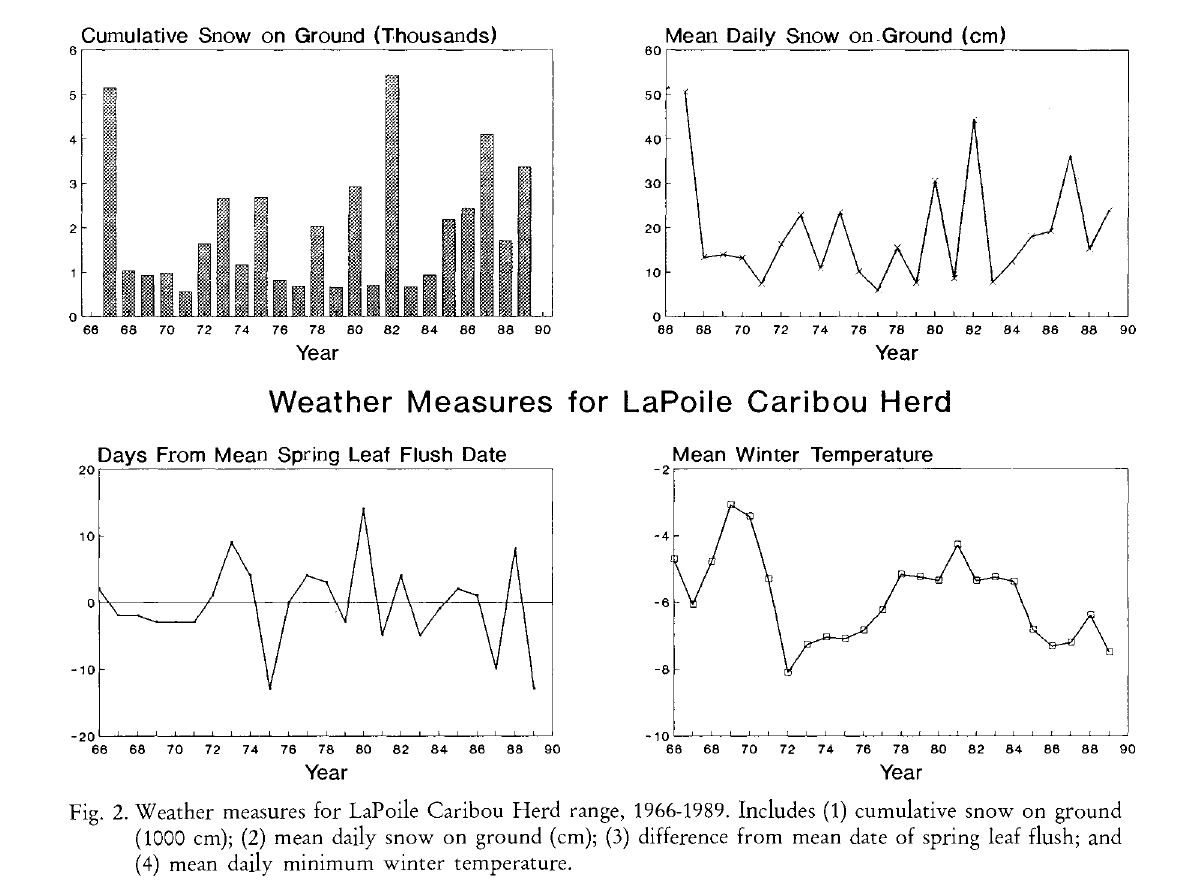
Fig. 2. Weather measures for LaPoile Caribou Herd range, 1966-1989. Includes (1) cumulative snow on ground (1000 cm); (2) mean daily snow on ground (cm); (3) difference from mean date of spring leaf flush; and (4) mean daily minimum winter